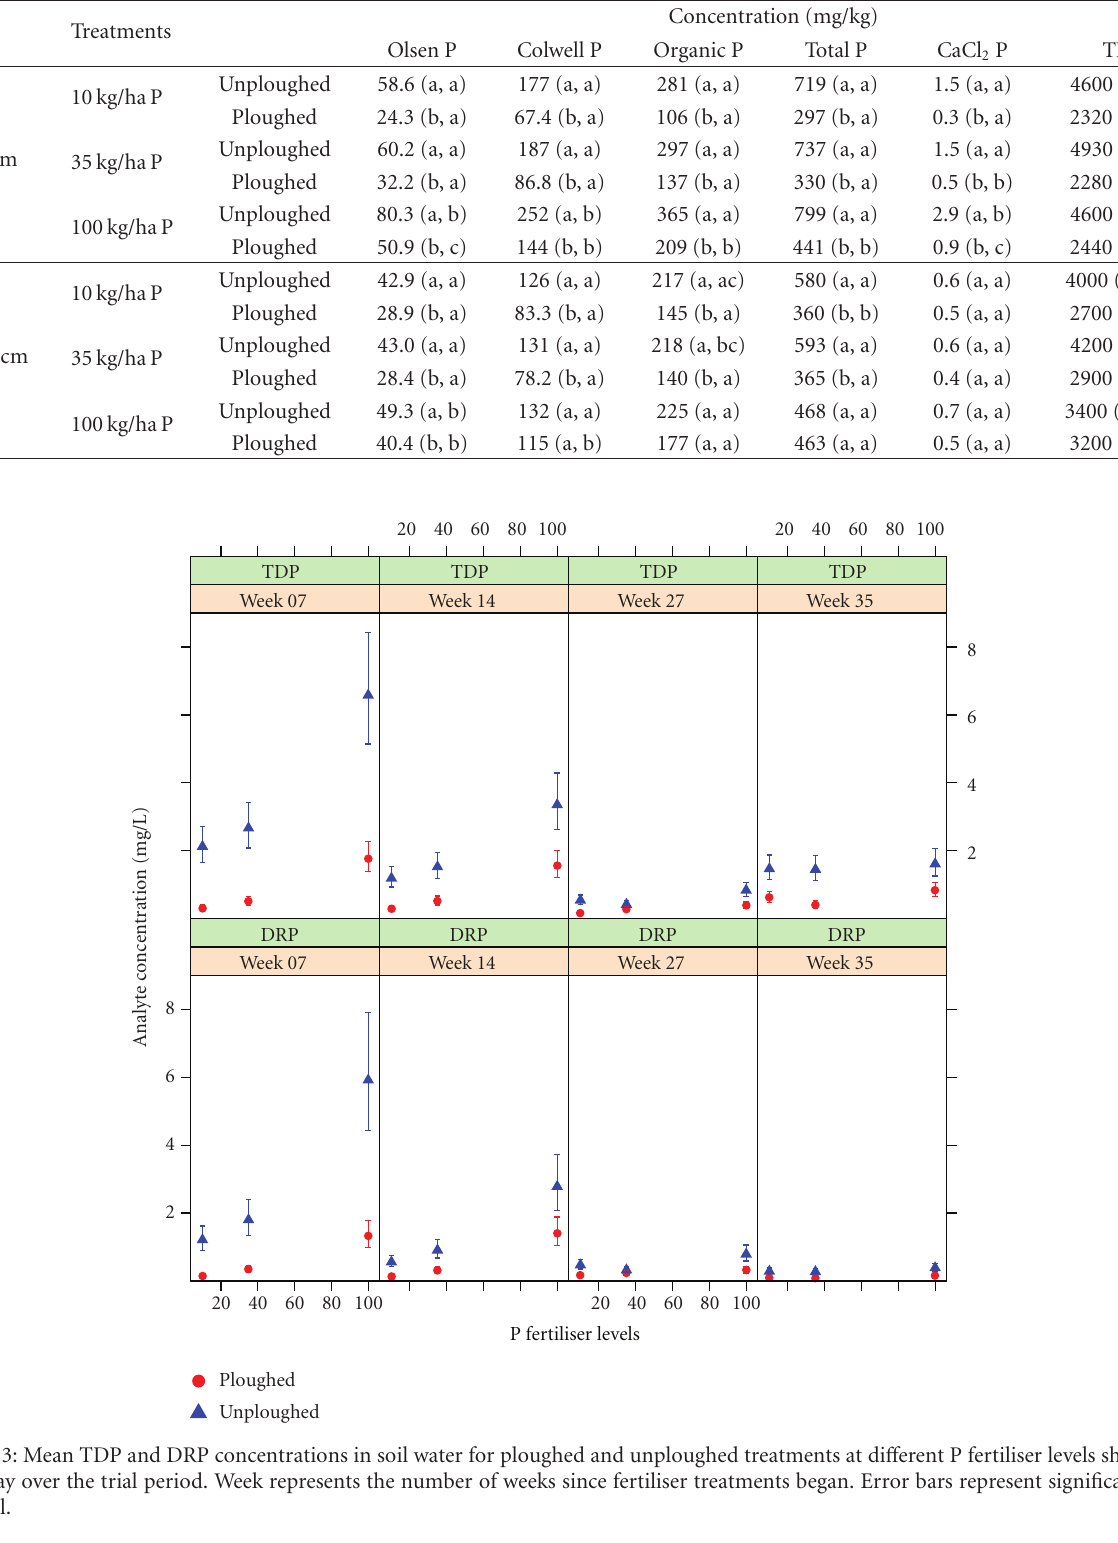
Table 3: Mean values of soil fertility tests for both the 0–20 mm and 0–100 mm soil depths after fertiliser treatments were applied. Values in brackets represent significance at 5% level. Values before the comma compare ploughed versus unploughed within a fertiliser treatment, while values after the comma compare fertiliser treatments with identical sod preparation. Within a row, items with the same letter are not significantly di ff erent when comparing 0–20 mm together or comparing 0–100 mm together (significant tests have not been applied between di ff erent depths).